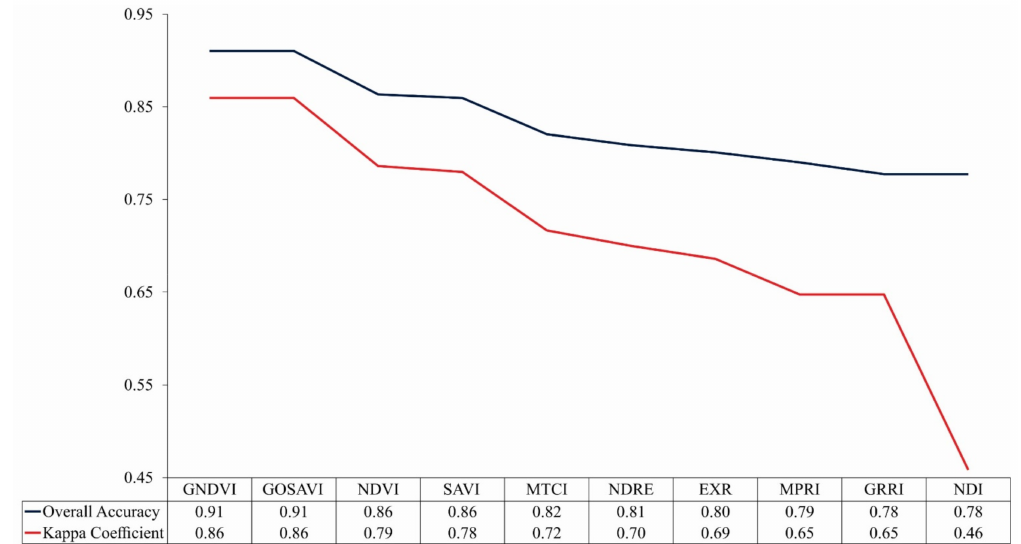
Figure 4. Overall accuracy and kappa coefficient for image classification through Random Forest (RF) from vegetation indices. It was possible to notice that vegetation indices that use a combination of the near- infrared band with bands in the visible spectral region presented better results.